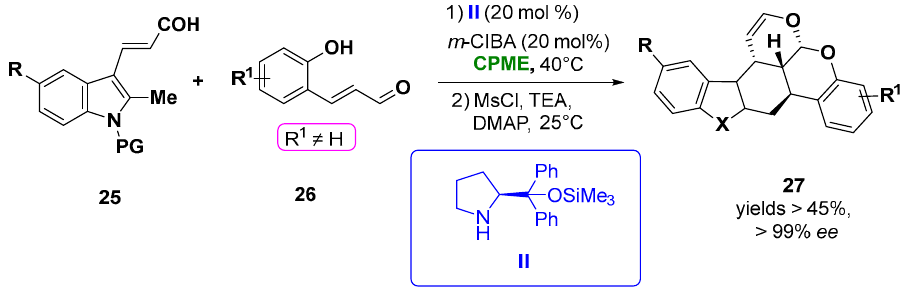
Figure 15. Synthesis of chiral carbazole derivatives from unsaturated indolyl-aldehydes and enals.